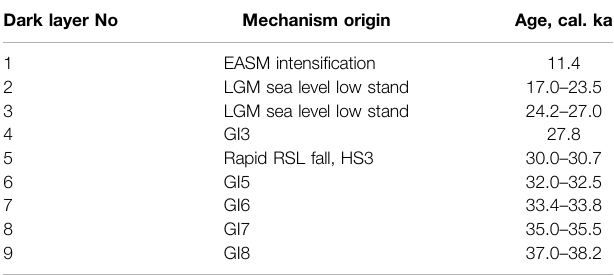
TABLE 2 | Ages of dark layer sequence in the Japan Sea over the last 40 kyr and mechanisms of its formation. Dark layer